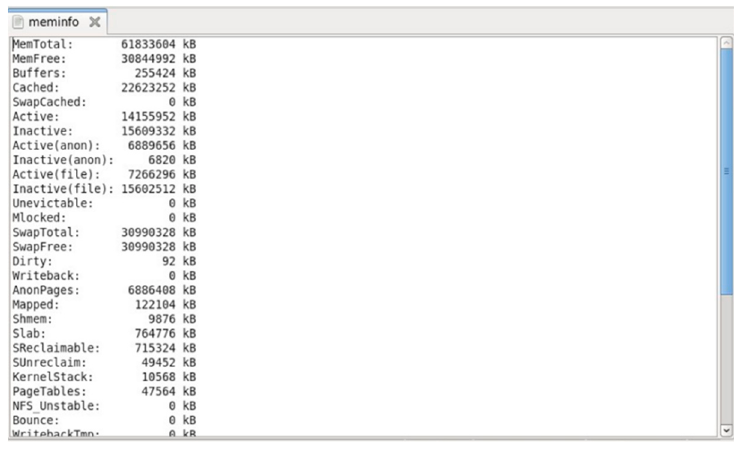
Figure 13. The meminfo file in Linux.